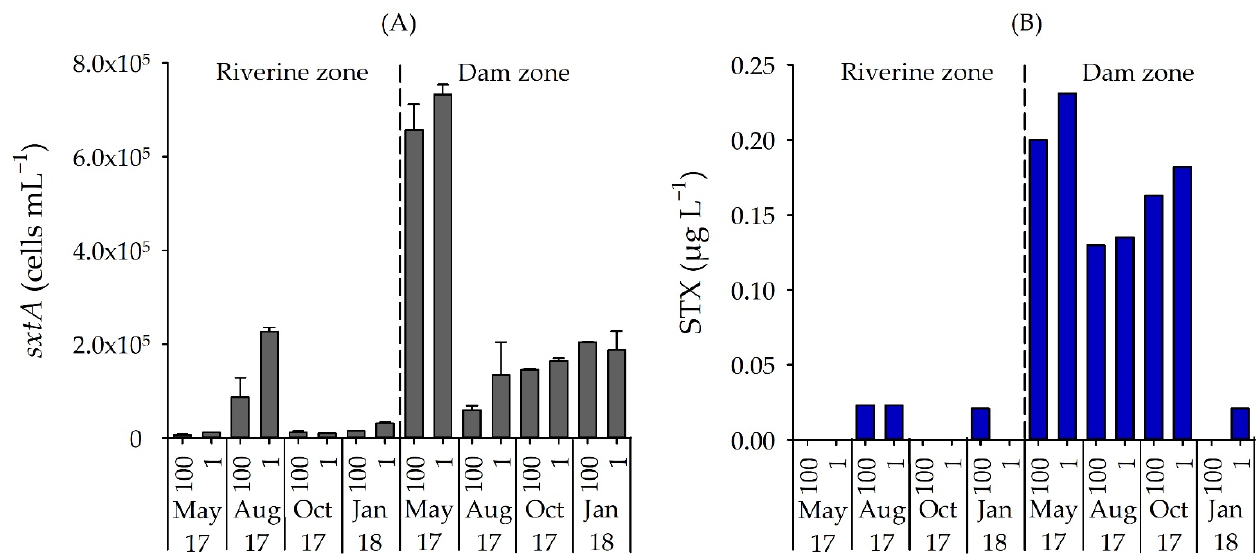
Figure 5. ( A ) Number of sxtA gene (cells mL − 1 ) and ( B ) STX concentration ( μ g L − 1 ) in samples from two field stations, in four months and two depths in Itupararanga reservoir. Standard deviations of triplicate samples shown. 100 = surface; 1 = lower limit of euphotic zone.